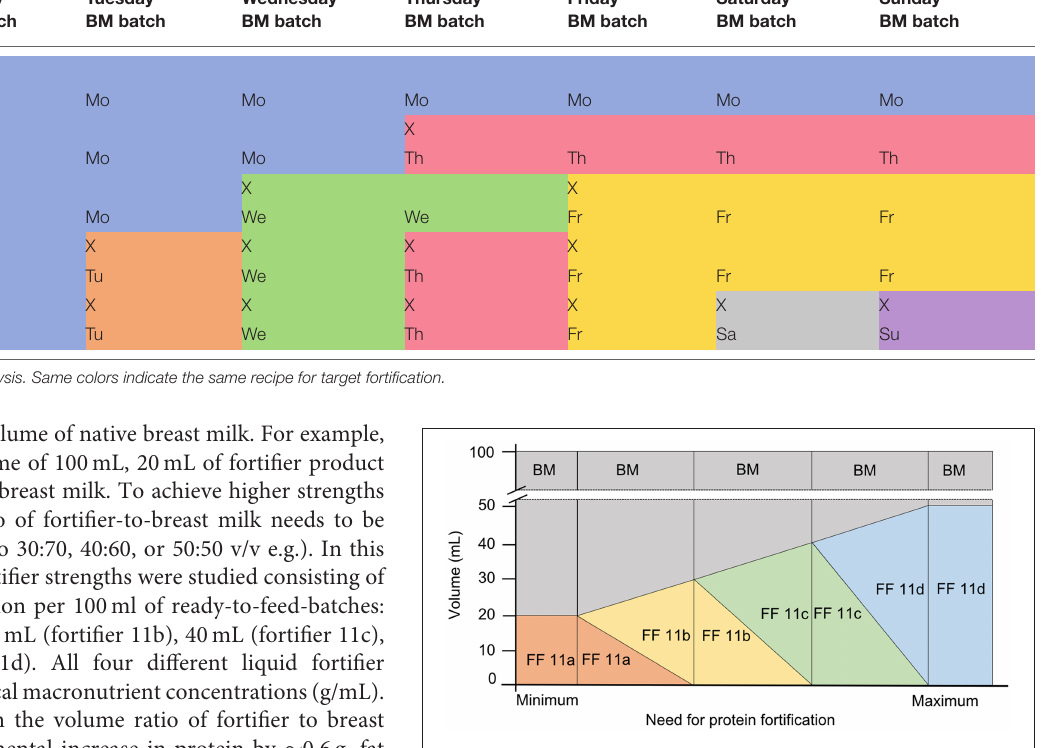
TABLE 2 | Different schedules of target fortification analysis and recipe adjustment (BM—pooled native breast milk batch for 24h feeding). Approach